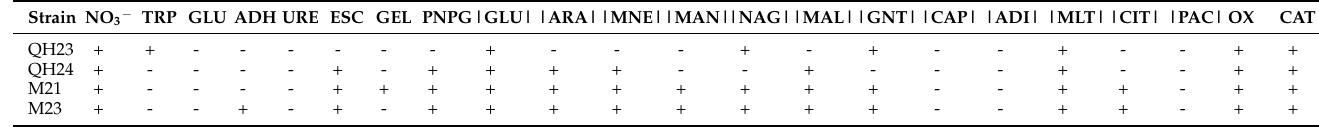
Table 2. Biochemical characteristics of bacterial strains.